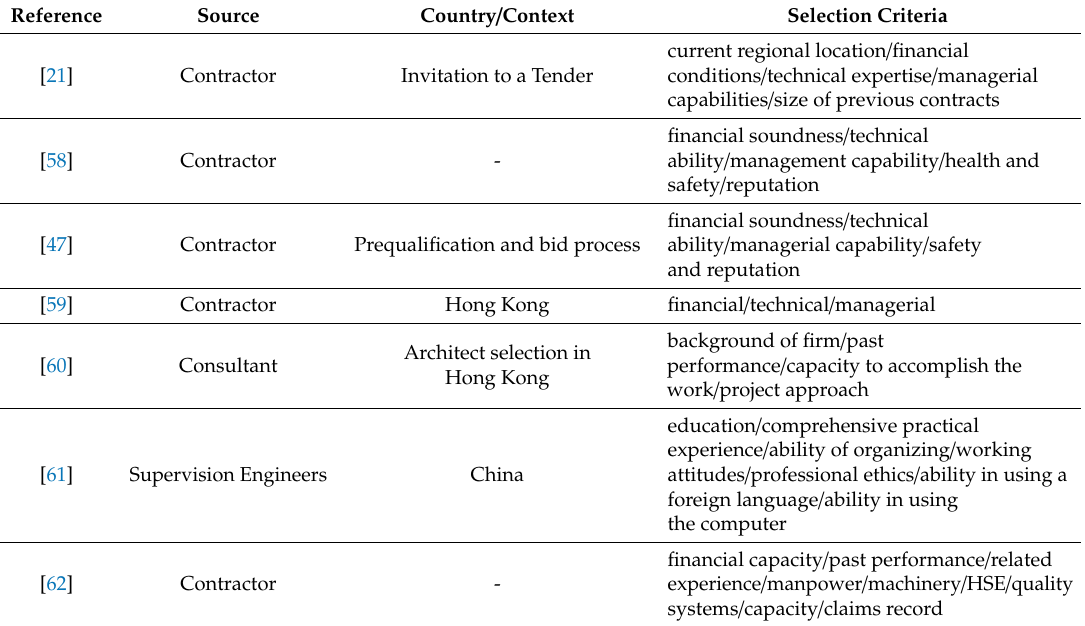
Table 1. Source selection criteria per sources based on the selected references in the